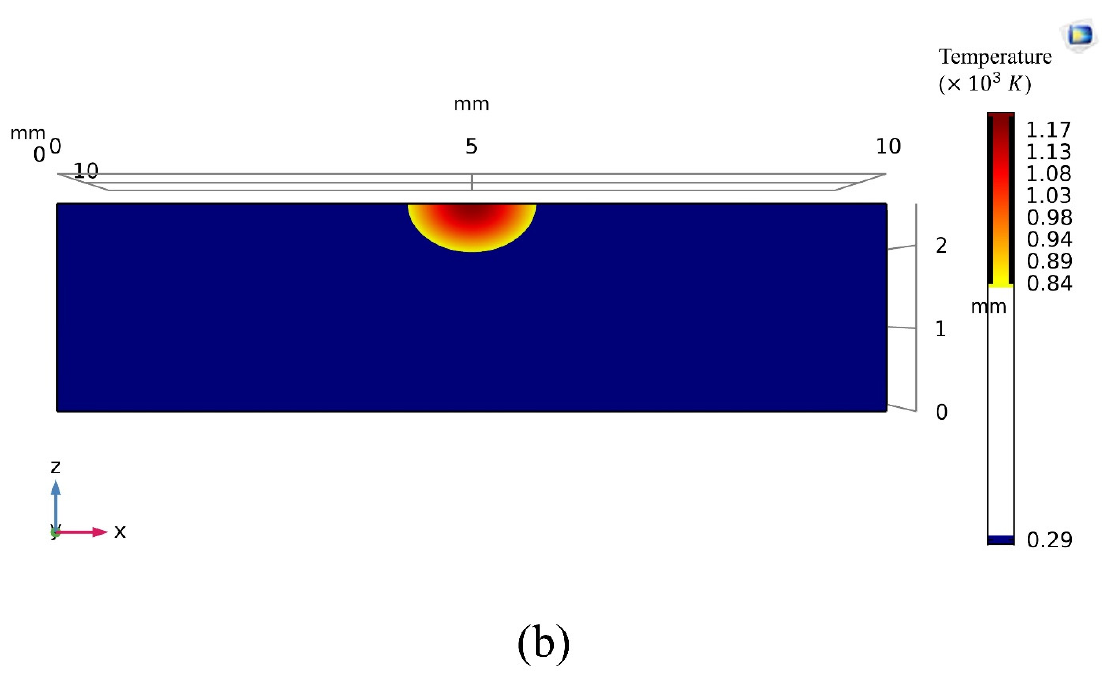
Figure 4. ( a ) Transverse-section ( x - z ) of the heat transfer; ( b ) molten pool achieved from the numerical modeling using an average laser power of 80 W , welding speed of 2 mm . s − 1 , and absorptivity of 0.36 at t = 4 ms .